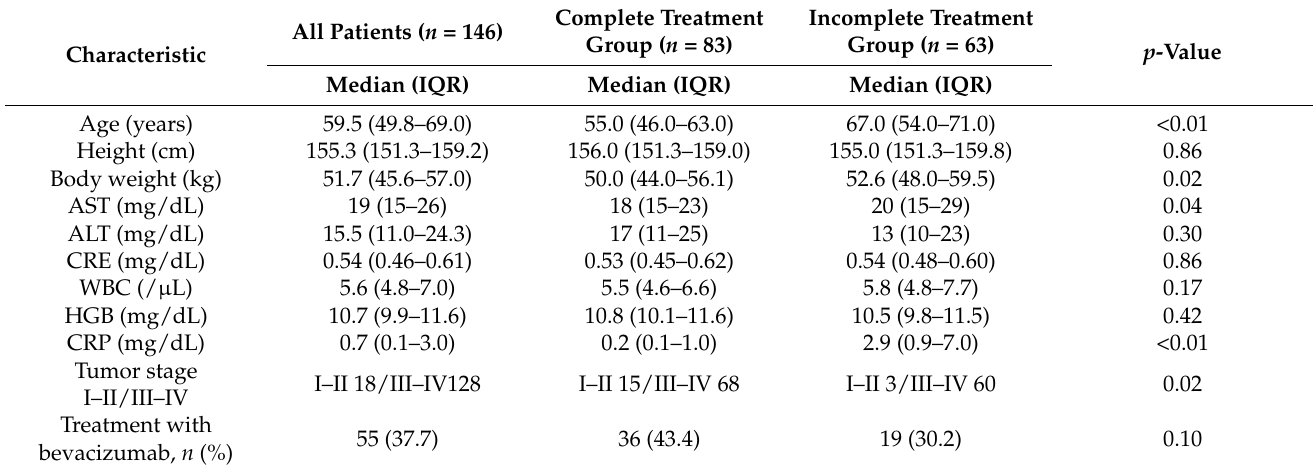
Table 1. Characteristics of patients.